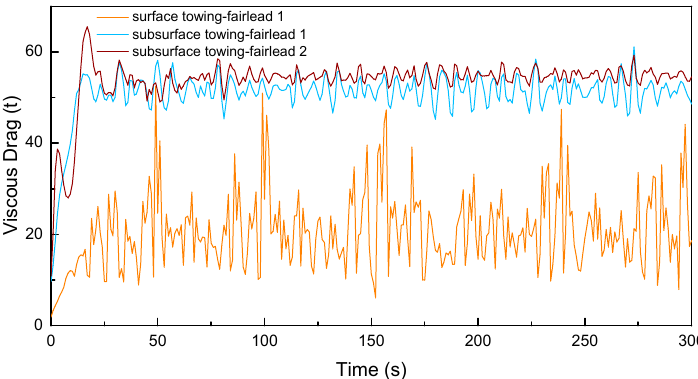
Figure 9. Comparison between the time history curves of the viscous drag force for surface towing and subsurface towing in terms of the fairlead position (towing speed: 3 m/s).